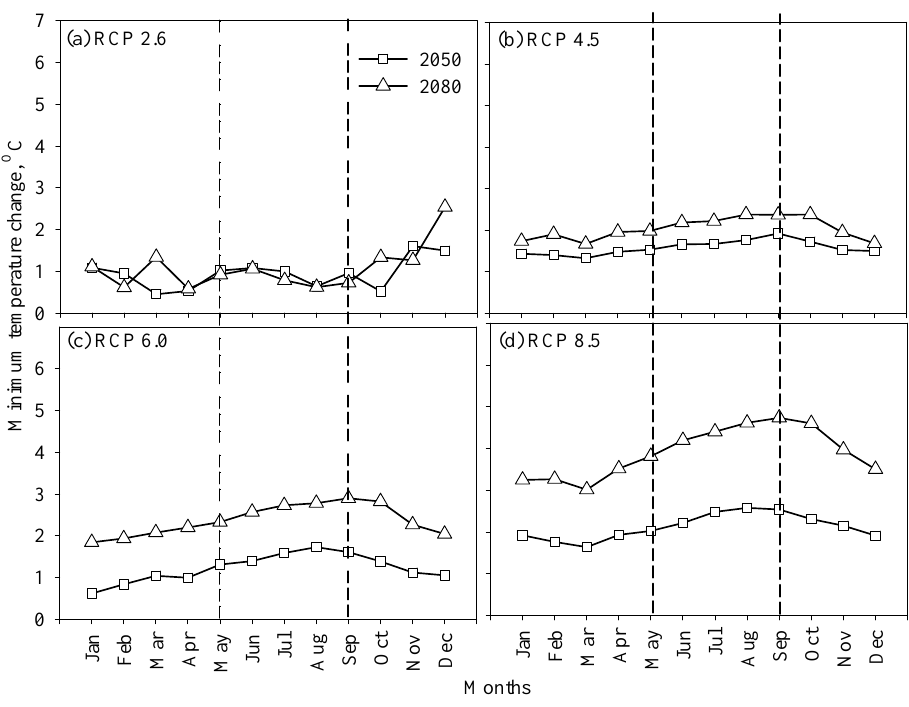
Figure 4. Coupled Model Inter-comparison Project Phase 5 (CMIP5) multi-climate model ensemble projected minimum temperature change at Stoneville, MS, for the four emissions scenarios of the Representative Concentration Pathways (RCPs), RCP 2.6 ( a ), 4.5 ( b ), 6.0 ( c ), and 8.5 ( d ), as used in the IPCC Fifth Assessment Report. Dotted lines in the vertical demarcate the normal cotton growth season (May to September).